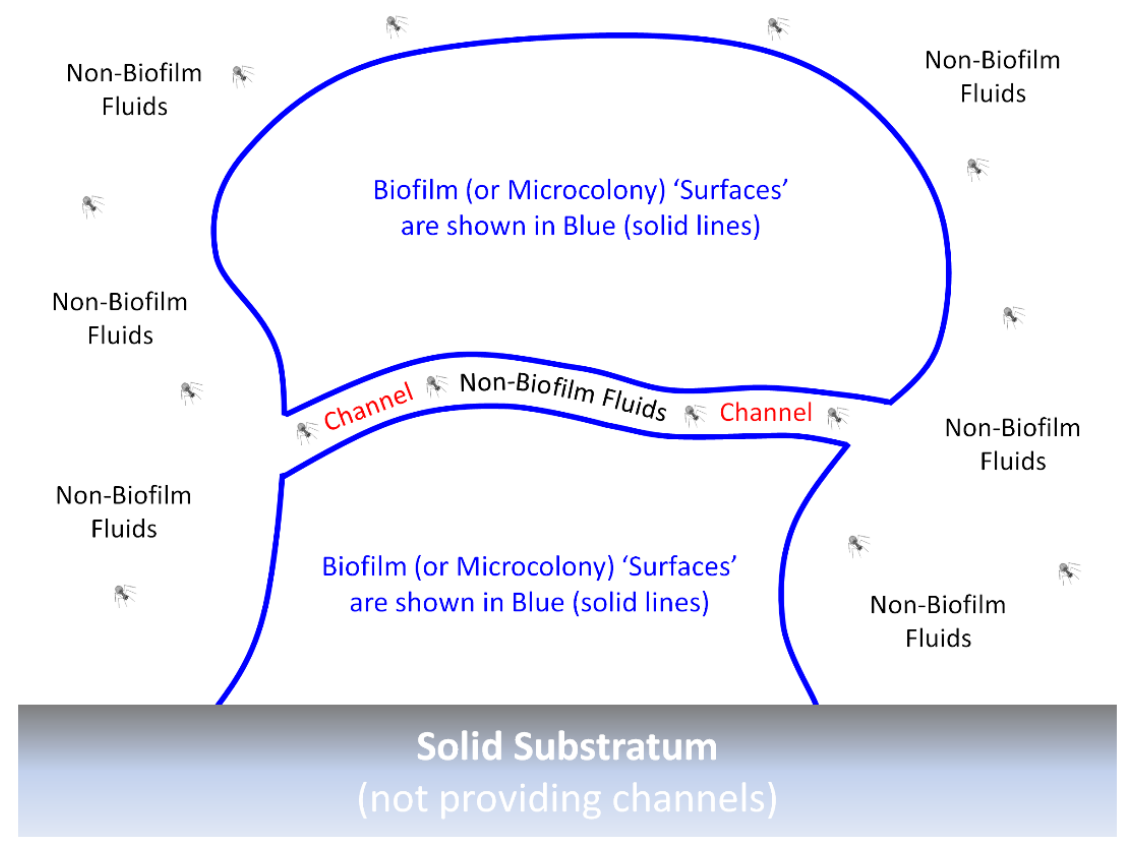
Figure 3. An idealized biofilm or biofilm microcolony. The “surfaces” of biofilms or microcolonies are sufficiently in contact with non-biofilm fluids that phage encounter may occur without virions penetrating much beyond a single “surface” layer of bacteria. These surfaces can include the walls of any channels that may be found within the biofilm, which would be relevant here particularly if those channels are wide enough to allow relatively easy virion passage. By analogy are various epithelial surfaces that are in contact with materials that are not body tissues, e.g., air or the contents of the gastrointestinal tract. Moreover, by analogy, such body surfaces are the primary locations of first encounter with potential pathogens, even though additional surfaces for such encounter can be created, as well, due to wounding. Actual channels—whether through biofilms, microcolonies, or bodies—would, of course, have three dimensions rather than the two dimensions depicted in the figure. Note also that biofilms can consist of individual or instead multiple microorganism species and that details of biofilm structure, such as of individual bacteria, as well as biofilm matrix filling the voids found between the blue lines, are not provided in the figure.